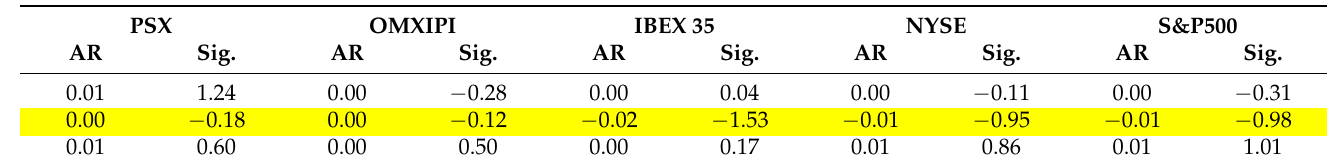
Table A17. Abnormal returns of the ( − 1, +1) event window (Prime Minister of Iceland announced his resignation).